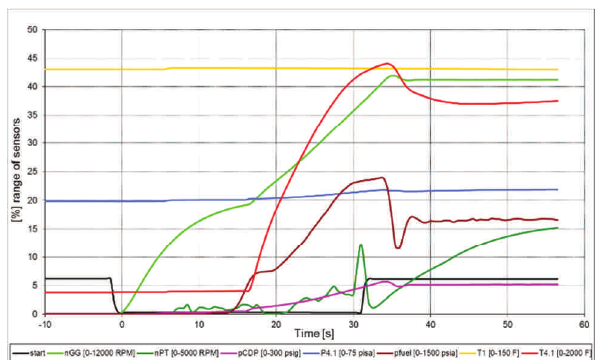
Fig. 4. Course of the relative values of control parameters for start-up of a naval gas turbine LM 2500